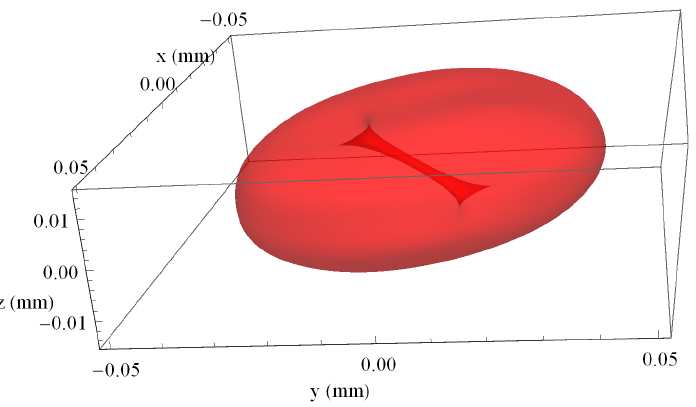
2 ) with initial PFT = 0.8 fs/mm, E | |